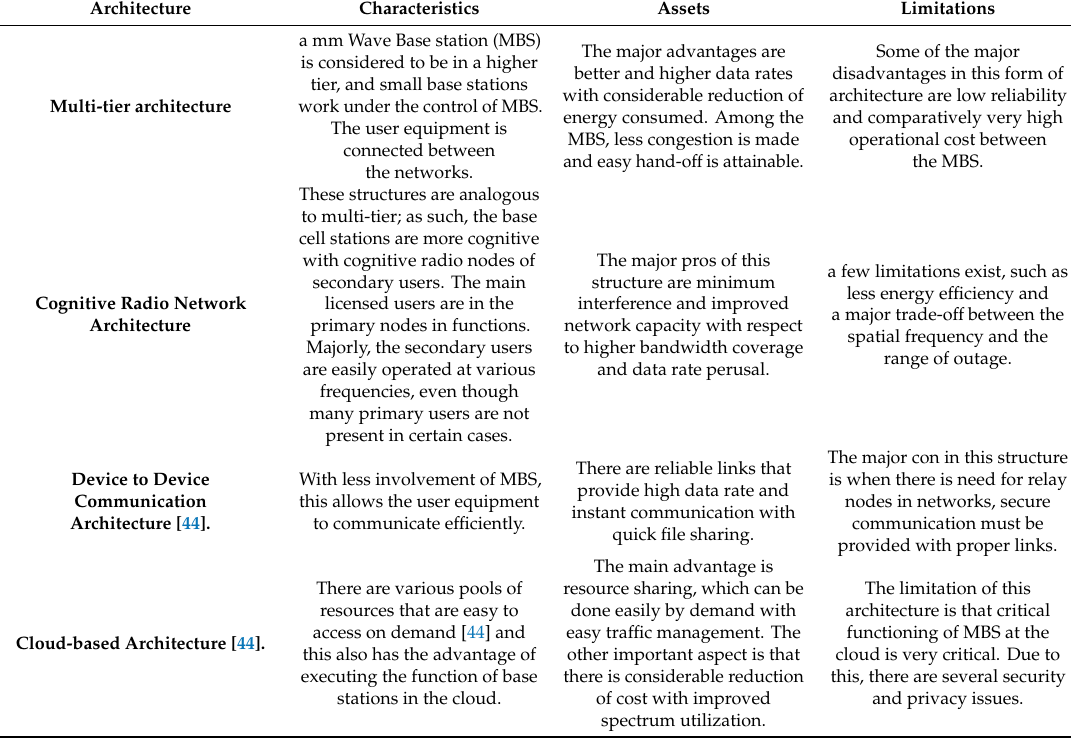
Table 2. Comparison between the existing fifth generation (5G)